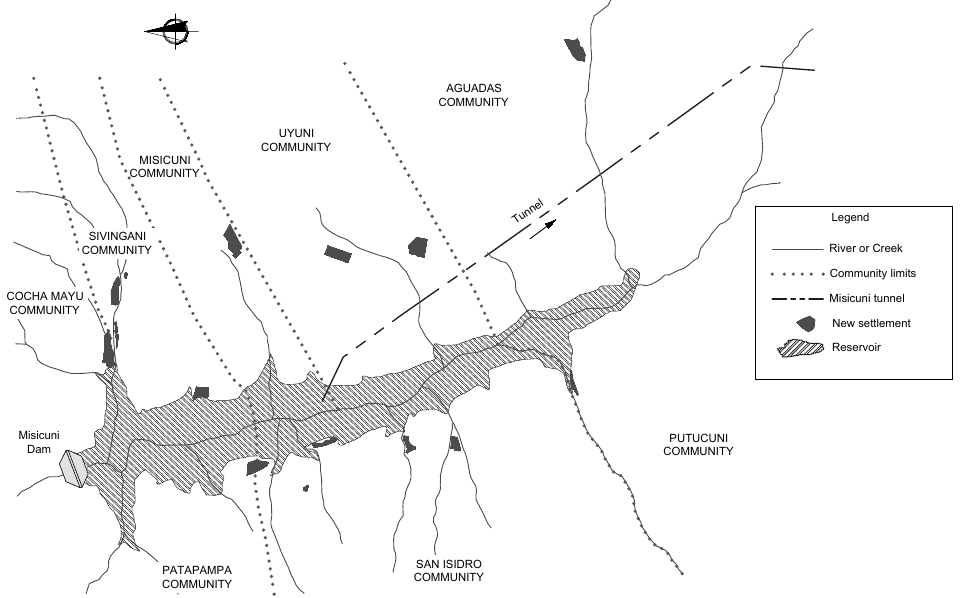
Figure 2. Communities in the Misicuni inundation area. Based on [38]; elaboration: Paul Hoogendam and Ronald